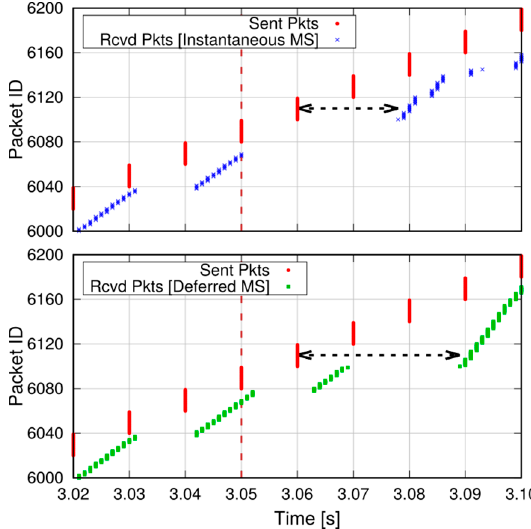
Figure 22. Effects of MS on a UDP-based application.